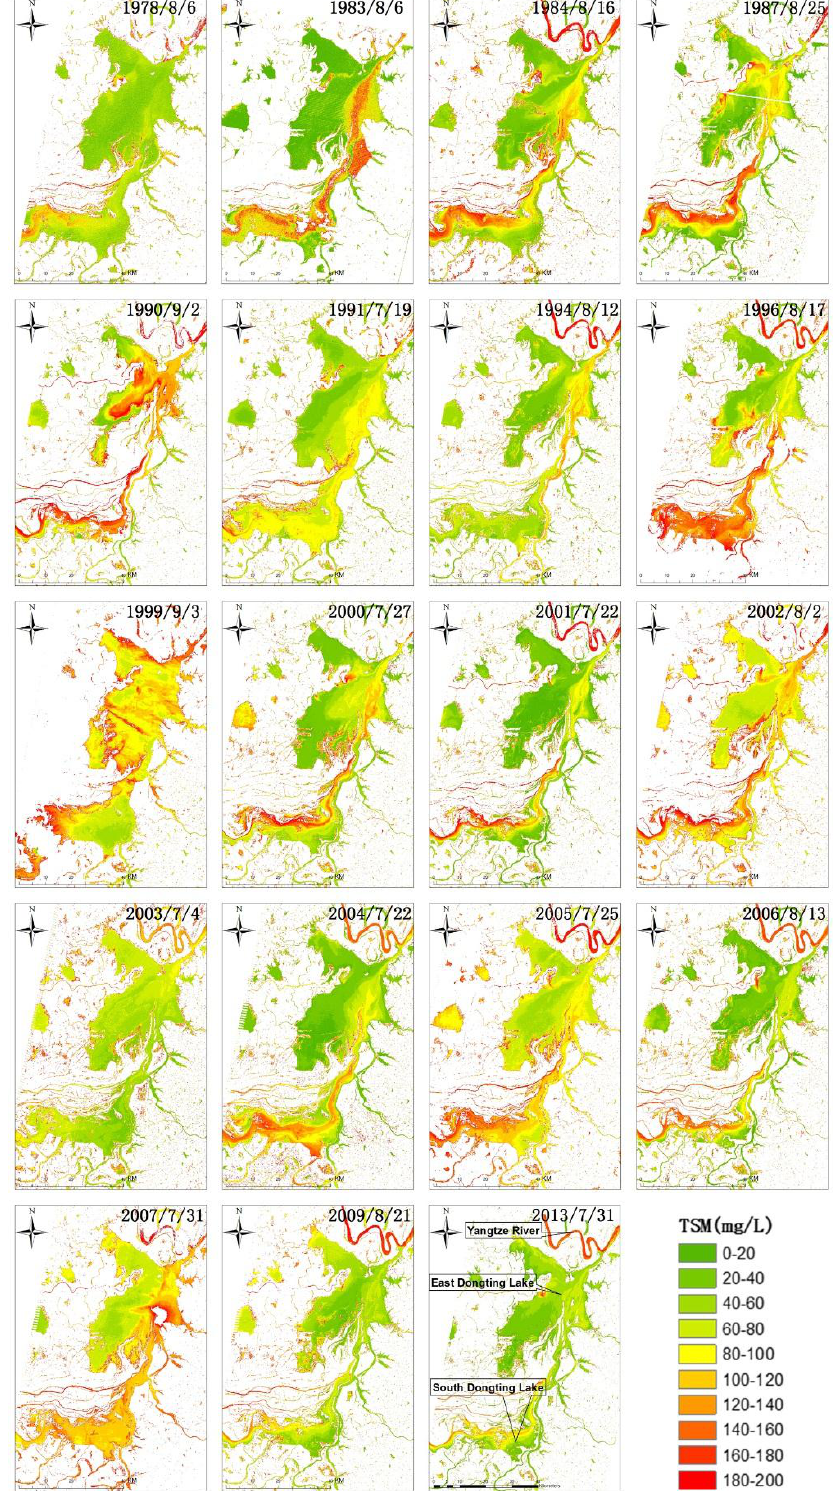
Figure 4. Derived-TSM pattern distribution snapshot map in the wet season at Dongting Lake from 1978 to